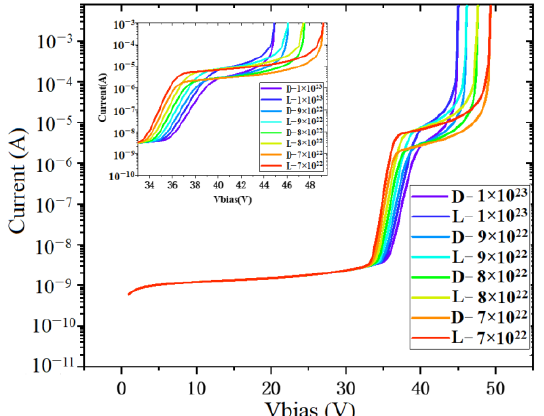
Figure 10. Characteristic curves of I-V at different doping concentrations, doping concentration unit: m − 3 . (Note. D: dark current; L: light current; the inserted figure is a partial enlargement of Figure 10).